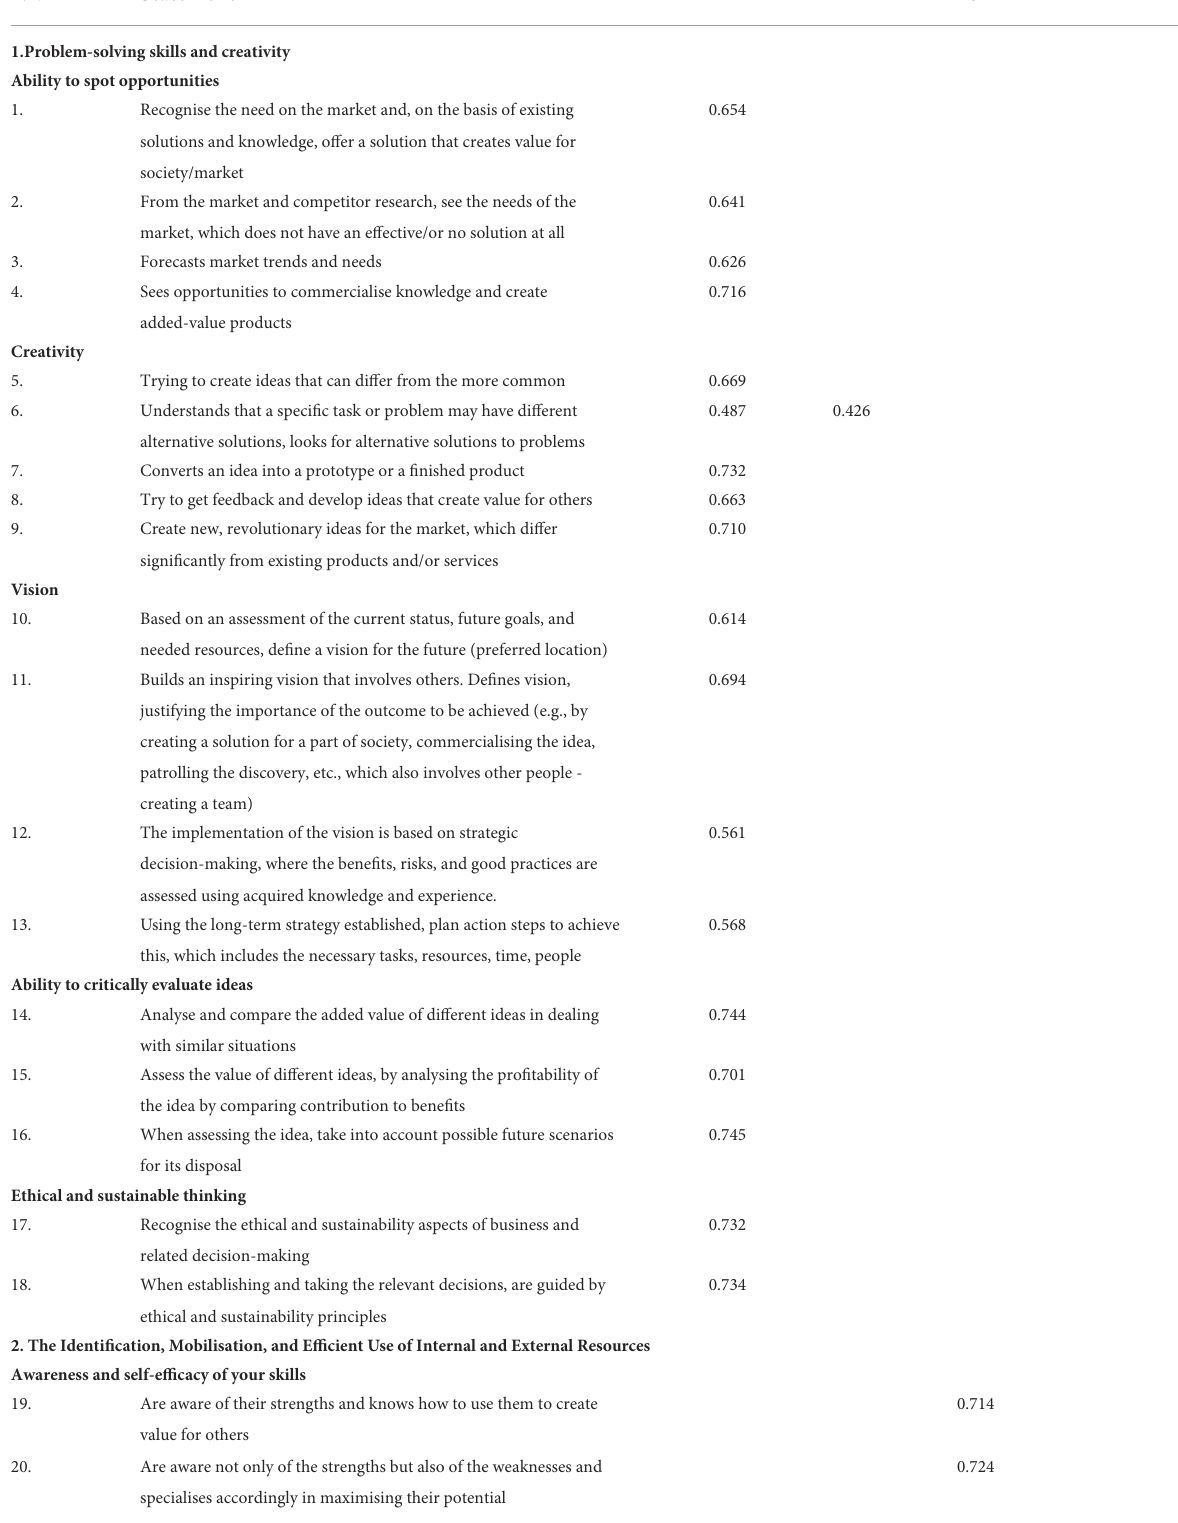
TABLE A1 Rotated factor matrix (Kaiser–Varimax rotation) for each entrepreneurship competences’ assessment statement (values below 0.400 are suppressed).